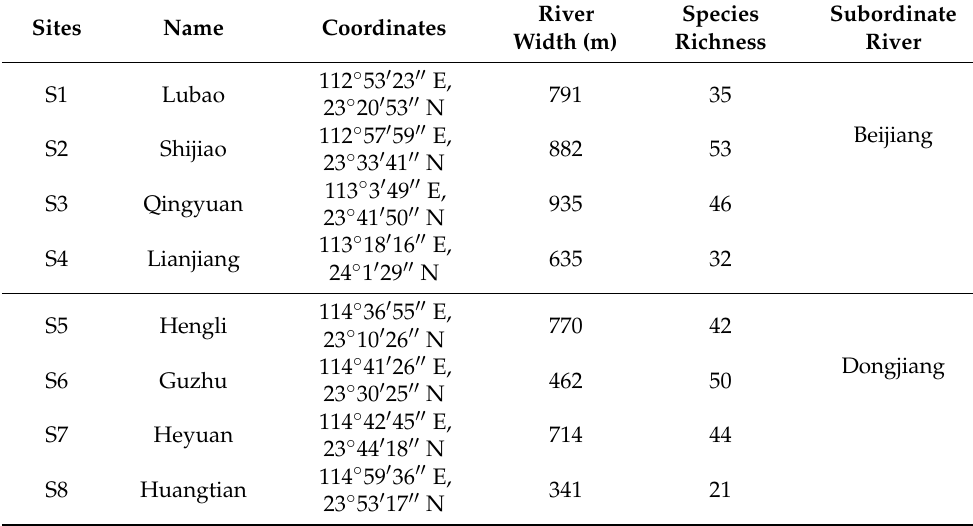
Table 1. Basic information of the sampling sites in the rivers.